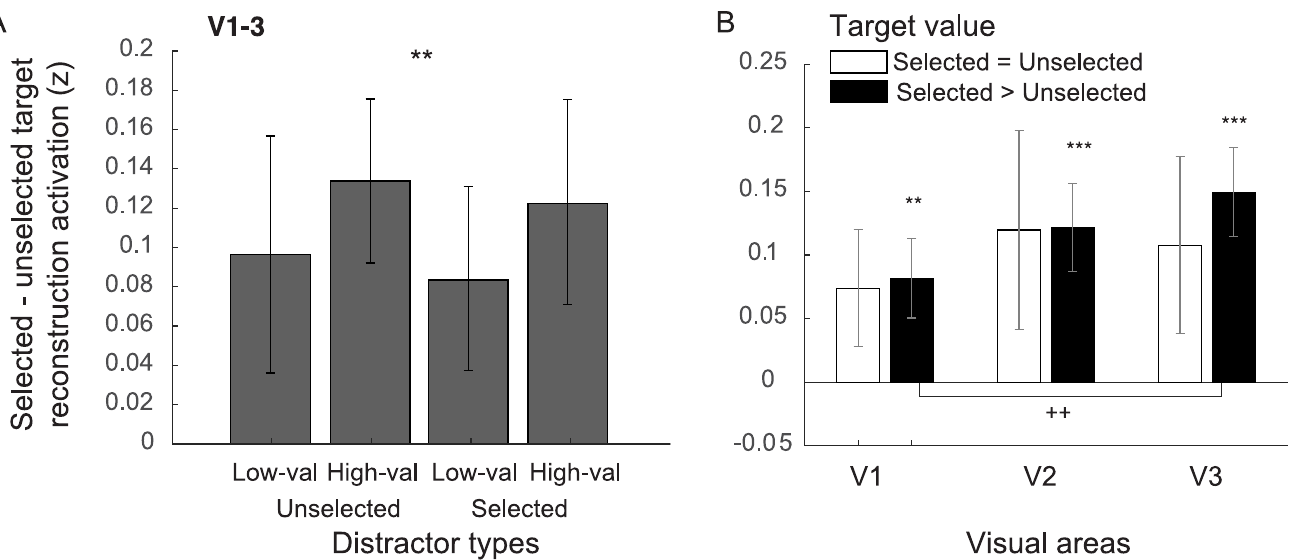
Fig 5. Target-selection modulations in early visual areas. (A) The difference between the selected and unselected target reconstruction activation for different target types. The activation values were obtained from averaging the reconstruction activation over circular spaces spanning the spatial extents of target stimuli (red and blue dashed circles in Fig 4A). The data in (A) were collapsed across visual areas. (B) The same data as (A) but plotted separately for different target-value conditions and for different visual areas. �� and ��� indicate significant target-selection modulations compared to 0 with p < 0.01 and < 0.001, respectively (2-tailed). ++ Significant difference across visual areas V1 and V3. Statistics in (B) were corrected for multiple comparisons with the Holm-Bonferroni method. All subfigures are plotted with ± 1 SEM. val, valued.